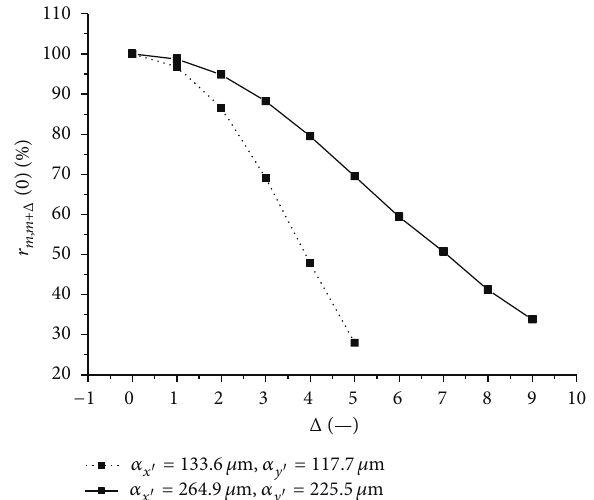
Figure 19: The correlation degree 𝑟 𝑚,𝑚+Δ (0) of the 1D normalized cross-correlation function of intensity signals from the rows 𝑚 and 𝑚 + Δ of the matrix detector as a function of the factor Δ for both larger ( 𝛼 𝑥 󸀠 = 264.9 𝜇 m and 𝛼 𝑦 󸀠 = 225.5 𝜇 m) and smaller ( 𝛼 𝑥 󸀠 = = 117.7 𝜇 m) speckle 133.6 𝜇 m and 𝛼 𝑦 󸀠